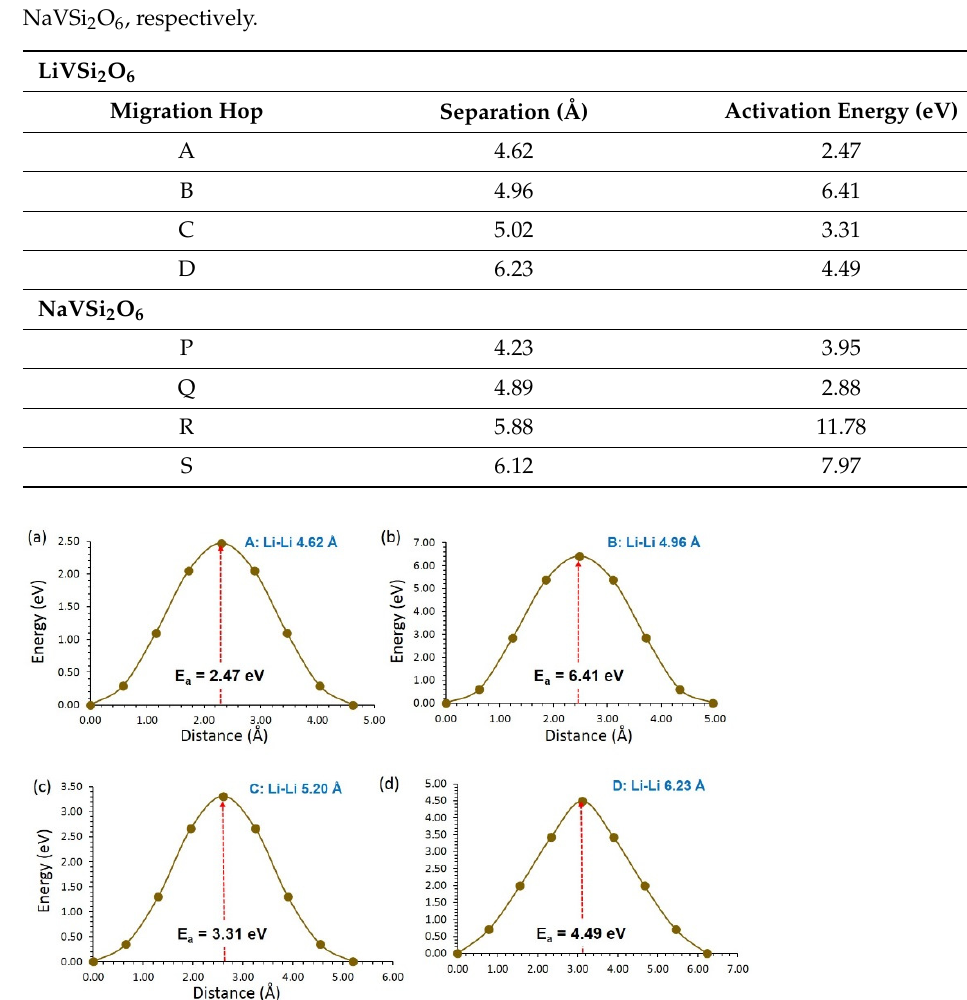
Figure 4. Energy profile diagrams for the local Li-ion hopping of ( a ) A, ( b ) B, ( c ) C and ( d ) D in LiVSi 2 O 6 .